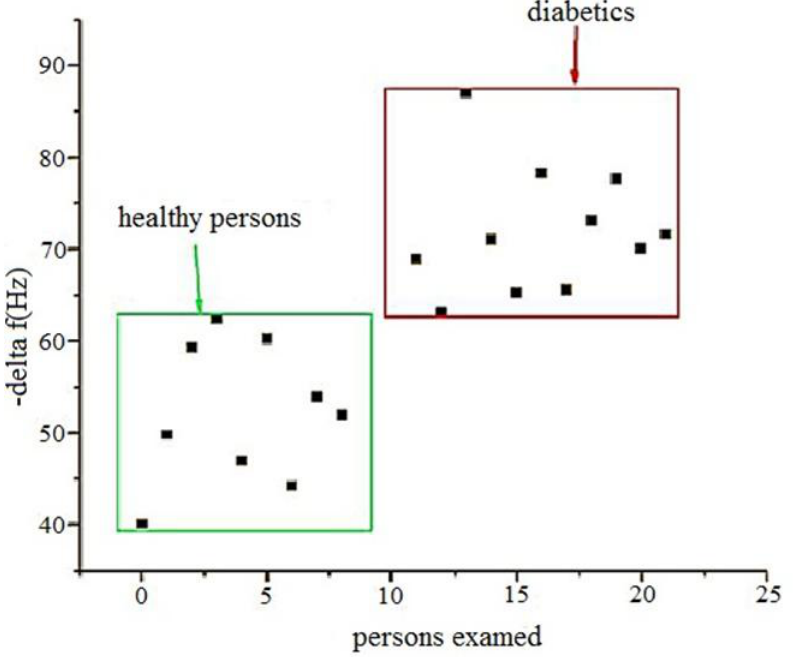
Figure 3. Breath analysis comparisons of healthy persons and diabetics using Ag-ZSM5 on a QCM device. (Adapted from Reference